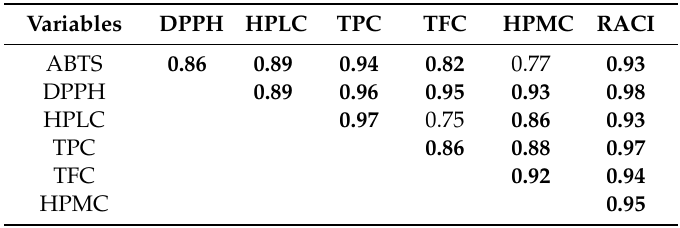
Table 4. Correlation matrix between TPC, TFC, total phenolics identified by HPLC (TPC–HPLC) and AO activity determined by ABTS, DPPH and HPMC assay.